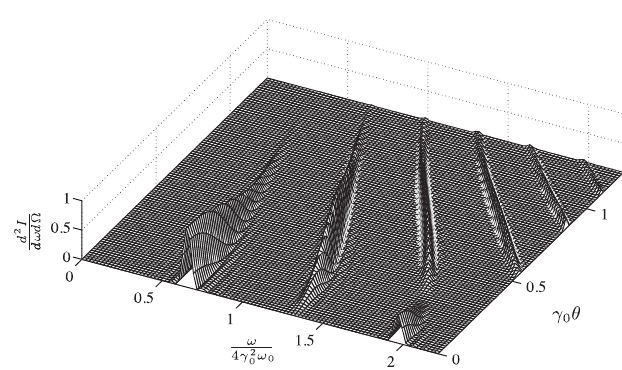
FIG. 6. The normalized spectral intensity as a function of normalized frequency, != 4 (cid:10) 2 0 ! 0 and angle (cid:10) 0 (cid:8) 0 of radiation scattered by a 5 MeV electron beam colliding with a linear polarized plane wave with a normalized vector potential of a 0 ¼ 1 . (cf. Ref. [28]).